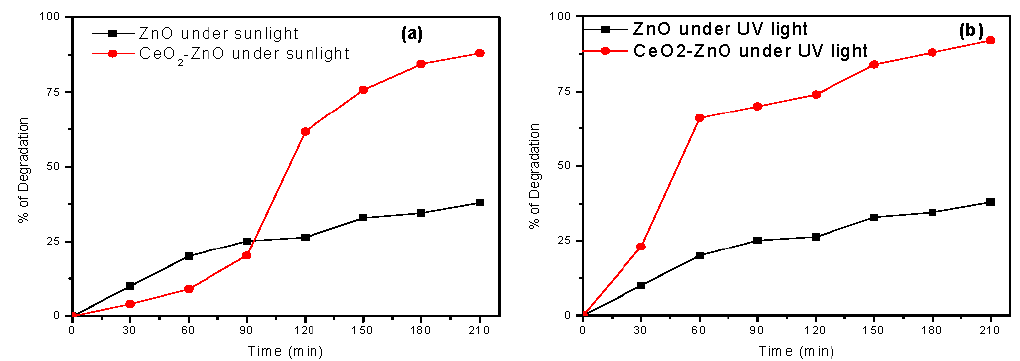
Figure 11. Photocatalytic degradation of MB dye of ( a ) ZnO and ( b ) CeO 2 -ZnO NPs.